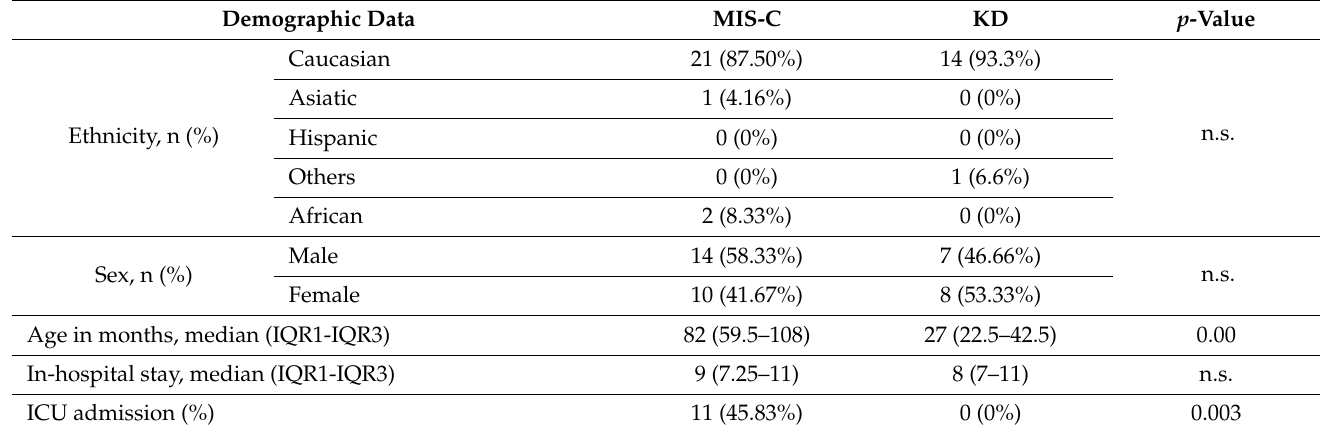
Table 1. Comparison between demographics and clinical features of MIS-C and KD